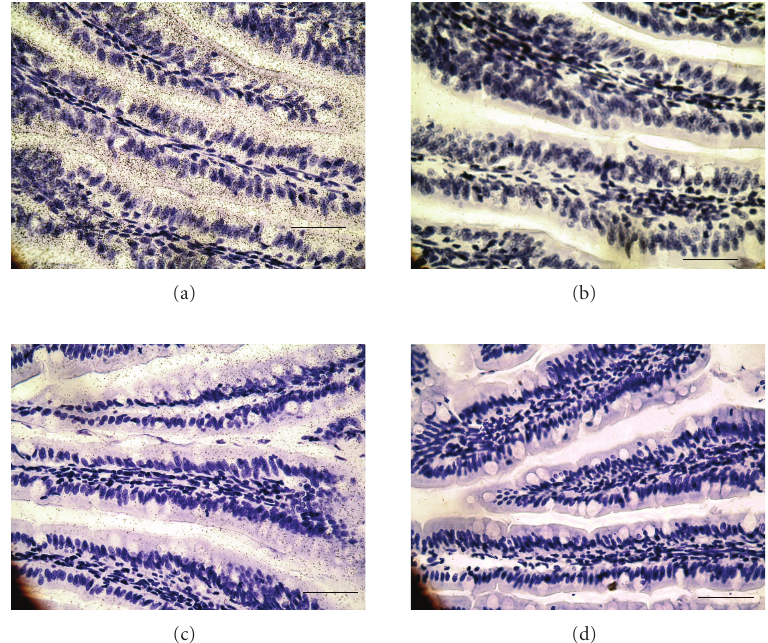
Figure 1: Localization of PLB mRNA in the jejunum of opossums fed the HCLF diet. Light-field autoradiographs of intestinal sections from the proximal third segment of a high responding opossum ((a) and (b)) and a low responding opossum ((c) and (d)). With the PLB antisense probe, strong hybridization signals were present in the villi of the high responder (a), but weak signals were present in the low responder (c). With the PLB sense probe, hybridization signals were barely detectable ((b) and (d)). Bar is 50 μ